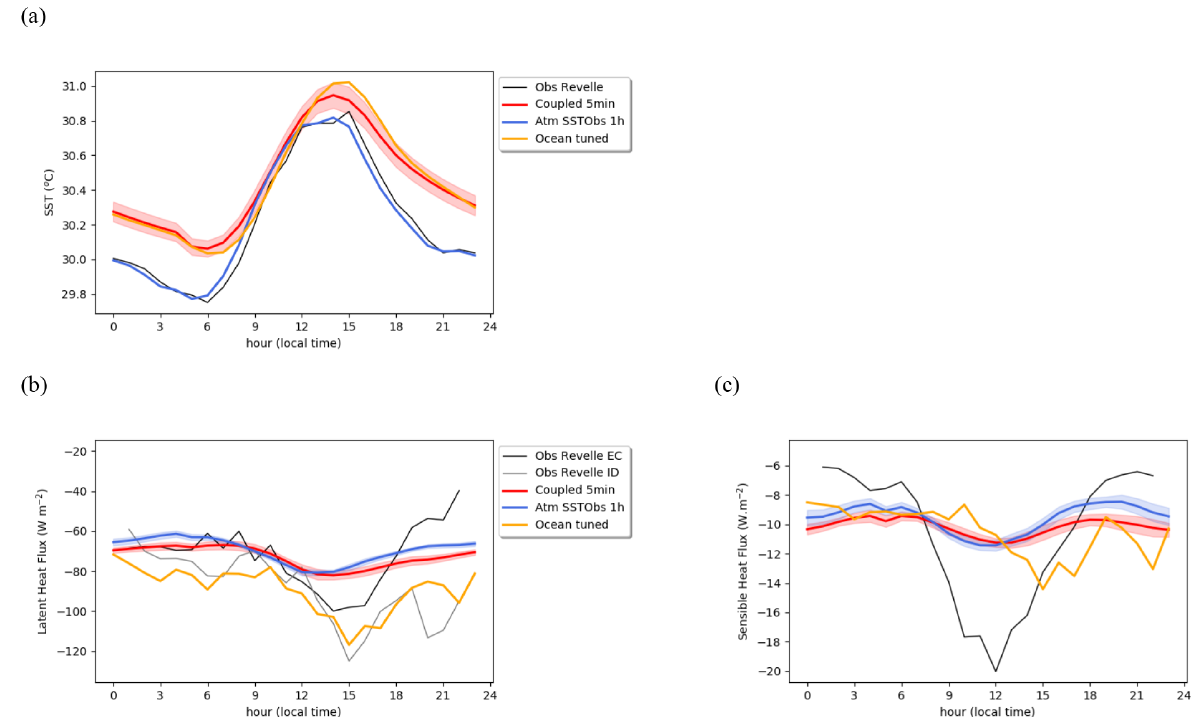
Figure 11. Mean daily cycle of (a) surface temperature ( ◦ C), (b) surface latent heat flux (Wm − 2 ), and (c) surface sensible heat flux (Wm − 2 ) averaged over the simulated period (13–22 November) for the coupled experiment (in red) and reference atmospheric (blue) and ocean forced (orange) experiments along with observations at the position of the R/V Revelle (black). The shading represents 2 standard deviations of the inter-member